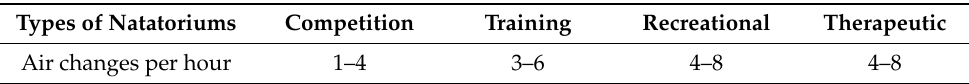
Table 2. Air change rates of different types of